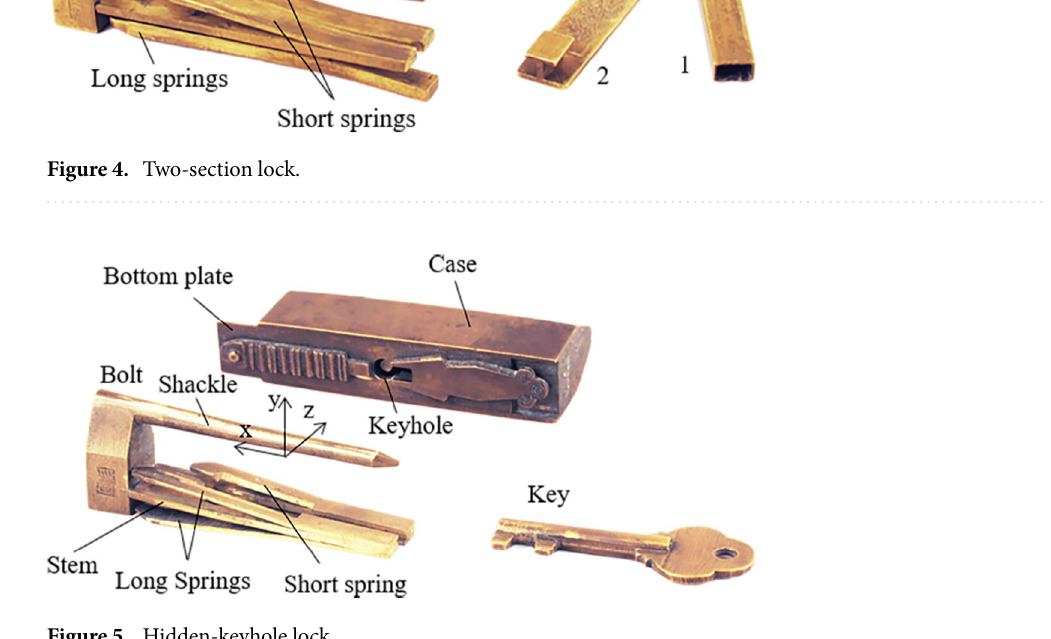
Figure 5. Hidden-keyhole